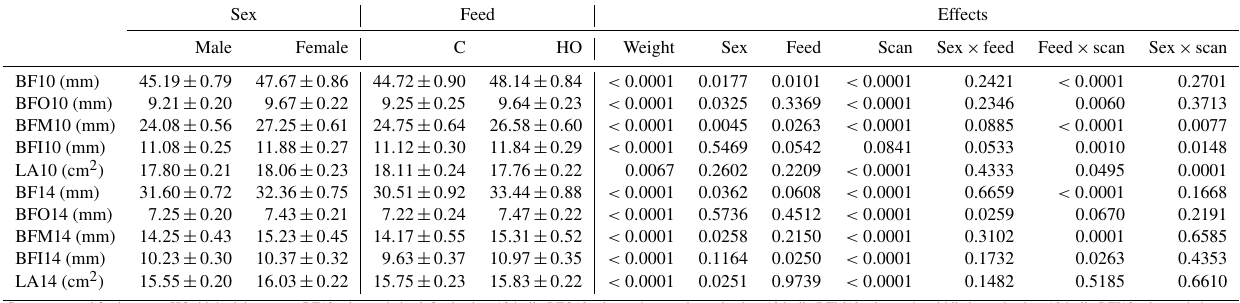
Table 2. Least squares means ( ± SE) for the data set of ultrasound traits studied by sex and feed and analysis of variance test. Sex Feed Effects